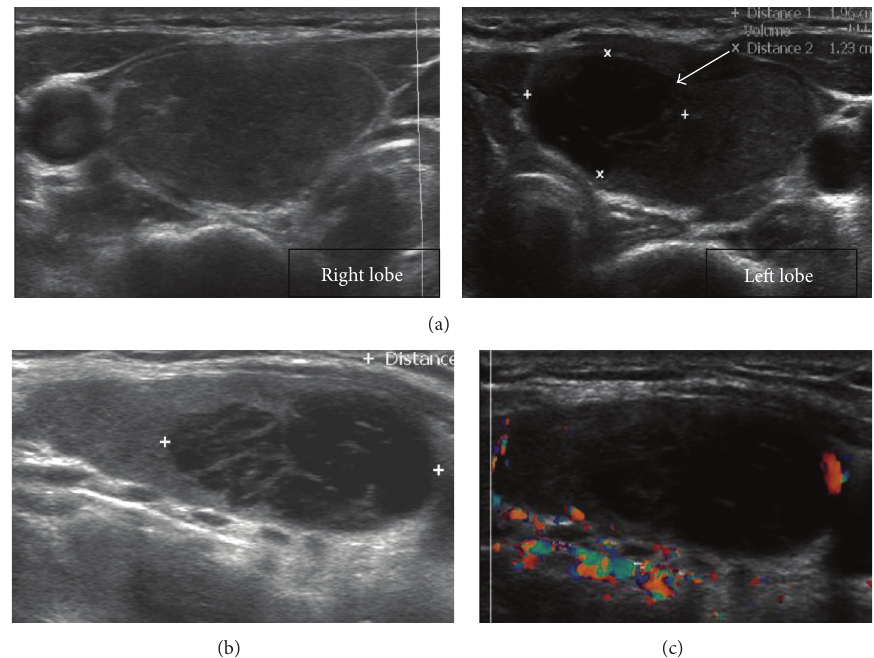
Figure 1: (a) Thyroid ultrasound shows a markedly hypoechoic area (arrow), with interspersed linear echogenic strands pattern in transverse view and (b) longitudinal view. (c) Color Doppler image shows a left thyroid nodule with peripheral increased blood flows in longitudinal view during a first visit.